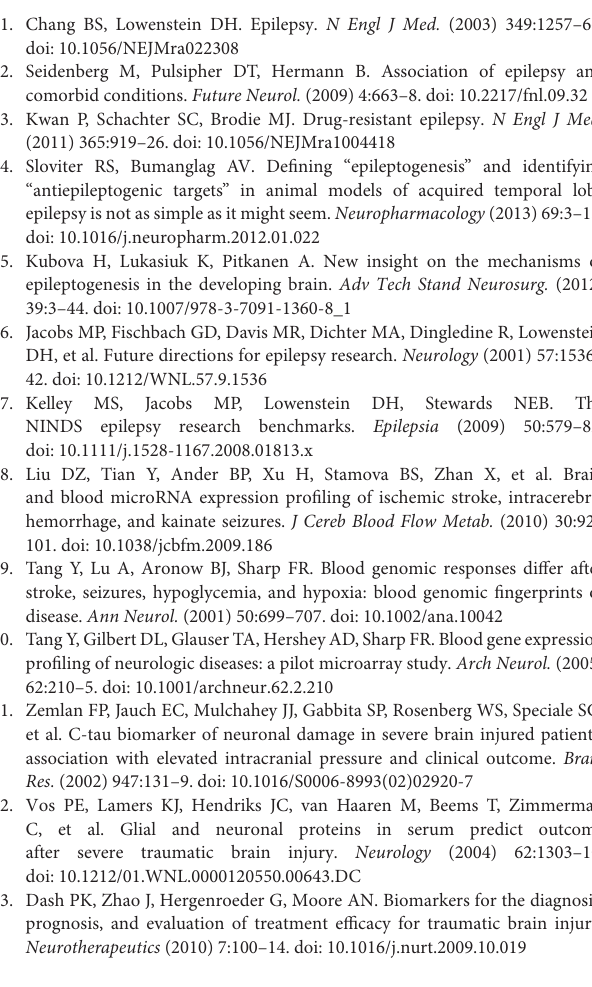
Supplementary Figure 1 | Proteomic analysis data. Supplementary Figure 2 | Original Western blotting images for KNG level in